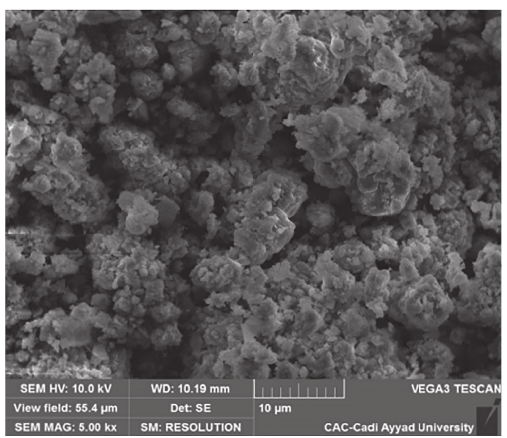
Figure 2: SEM of sugar scum powder.